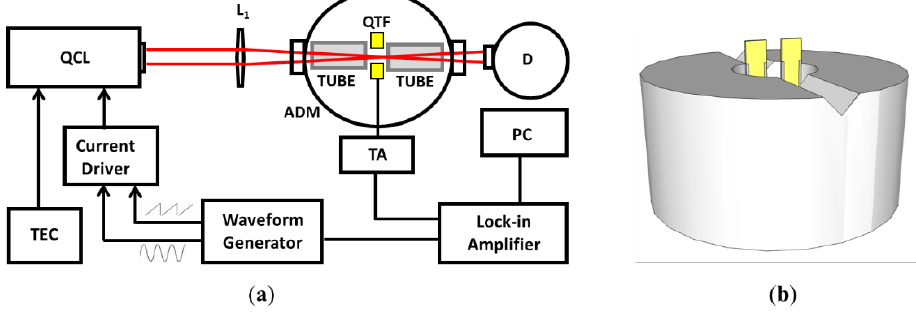
Figure 1. ( a ) Schematic of the quartz-enhanced photoacoustic spectroscopy (QEPAS) trace gas sensor system used. The laser beam is focused in the acoustic detection module (ADM) by means of a lens L 1 . TEC: temperature controller. PC: personal computer. TA: transimpedance amplifier. D: optical detector. ( b ) Sketch of the hollow metallic cylinder: the quartz tuning fork (QTF) is positioned in the center and tubes (not shown in the picture) are located on the V-groove.